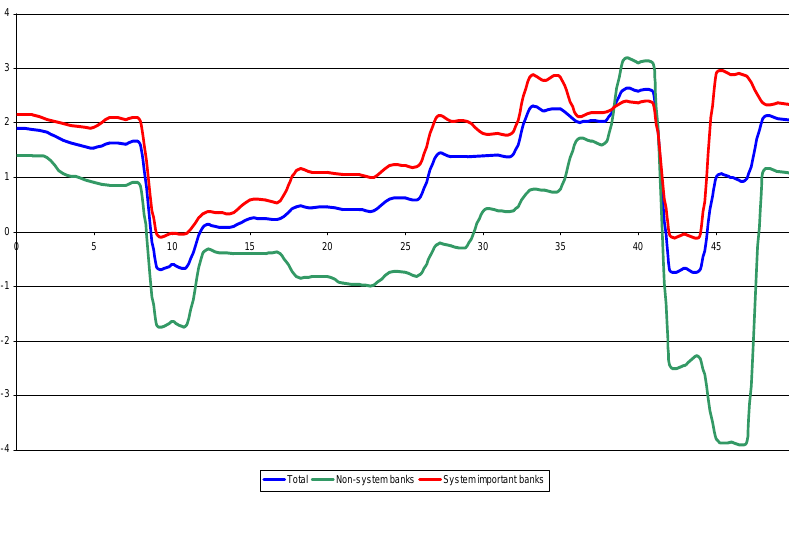
Figure 5. Dynamics of the financial stability index of all banks, systemically important banks and other